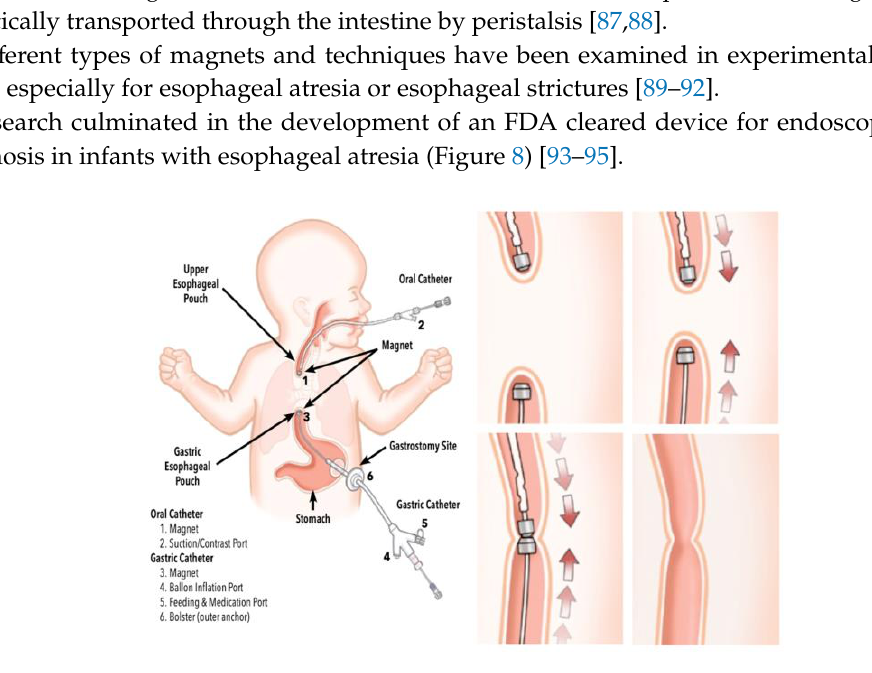
Figure 8. FDA-approved device for magnetic compression anastomosis in infants with long gap esophageal atresia. Magnamosis established by the Flourish ™ device. It consists of two catheters, each holding a magnet at its tip. The magnets placed at each end of the esophagus attract each other, causing the ends of the esophagus to stretch toward each other and eventually creating an anastomosis with the open passage of the esophagus. Figure taken from Morrow 2017 and www.cookmedical.com [93,96].